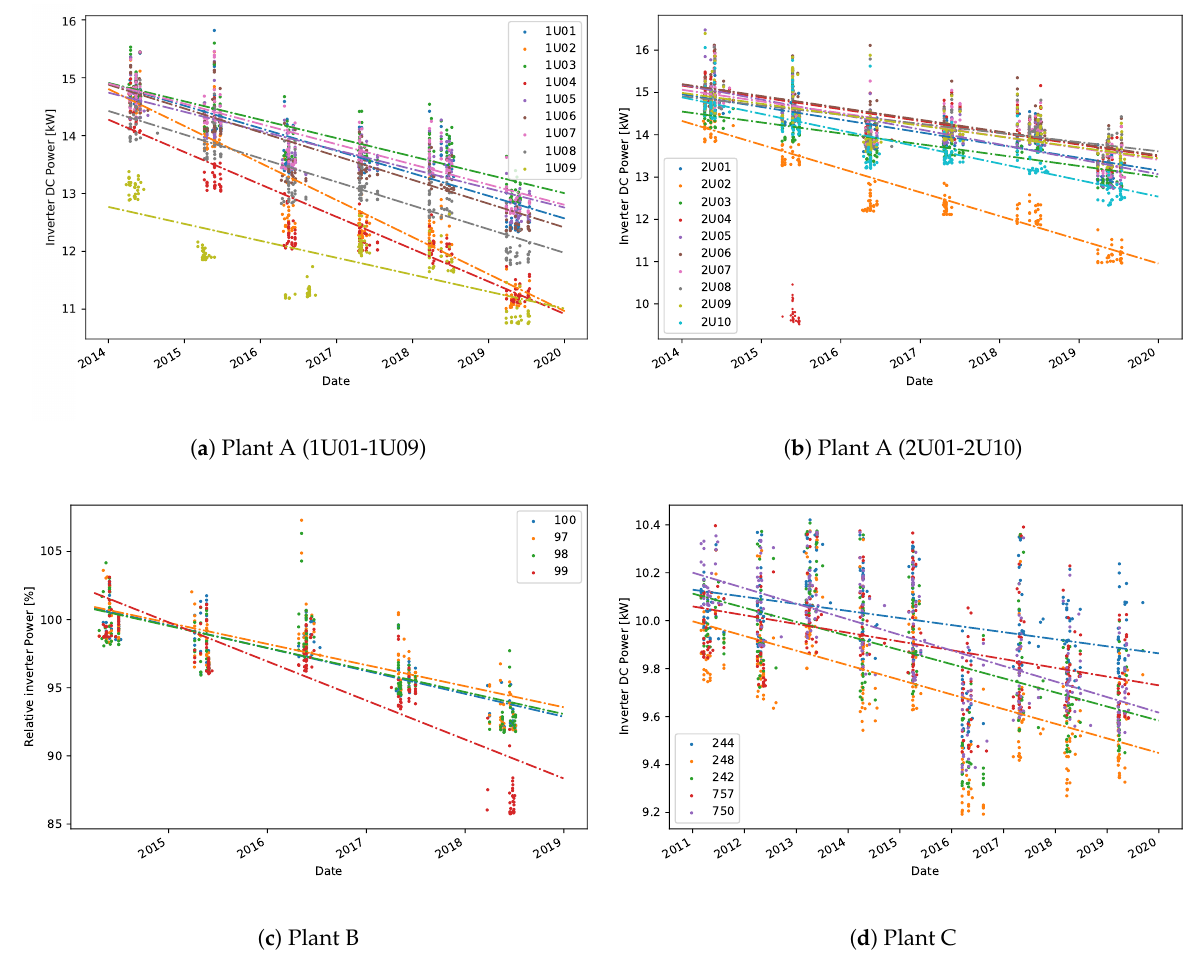
Figure 3. DC power degradation for all inverters in the plants calculated using the sampled values-based